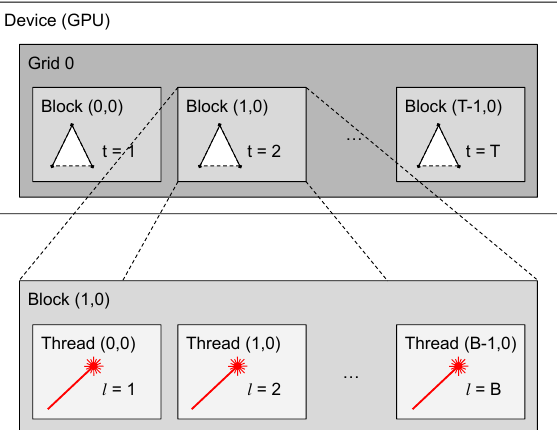
Figure 8. Parallel collision check approach. Triangles are organized in blocks and laser scans are organized in threads of these blocks. All collision checks are run